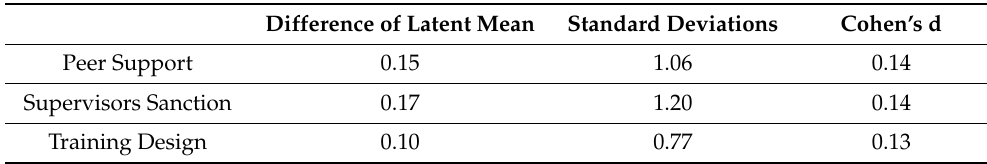
Table 9. Results of Difference